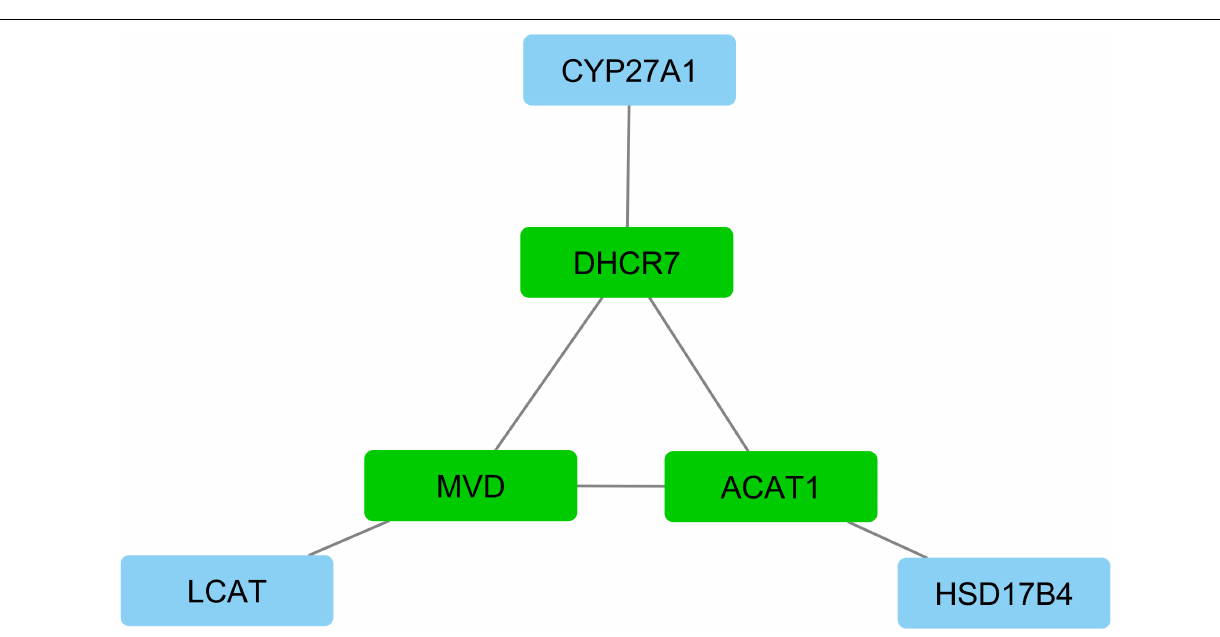
Frontiers in Genetics |